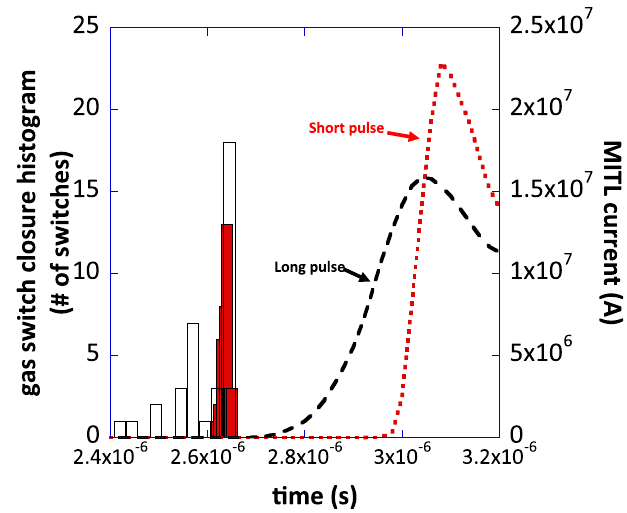
FIG. 10. (Color) MITL current pulse shapes as a function of gas switch closure